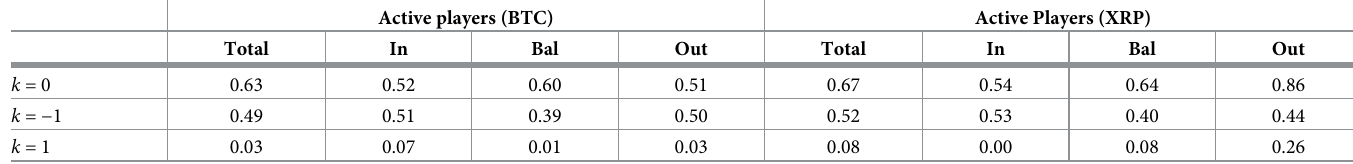
Table 5. Correlation between the time difference of price, Δ p ( t ), and the time difference of the number of Total, In, Bal, and Out active players, Δ N i ( t ). k represents the lag time. For example, k = 1 means the correlation between Δ p ( t − 1) and Δ N i ( t